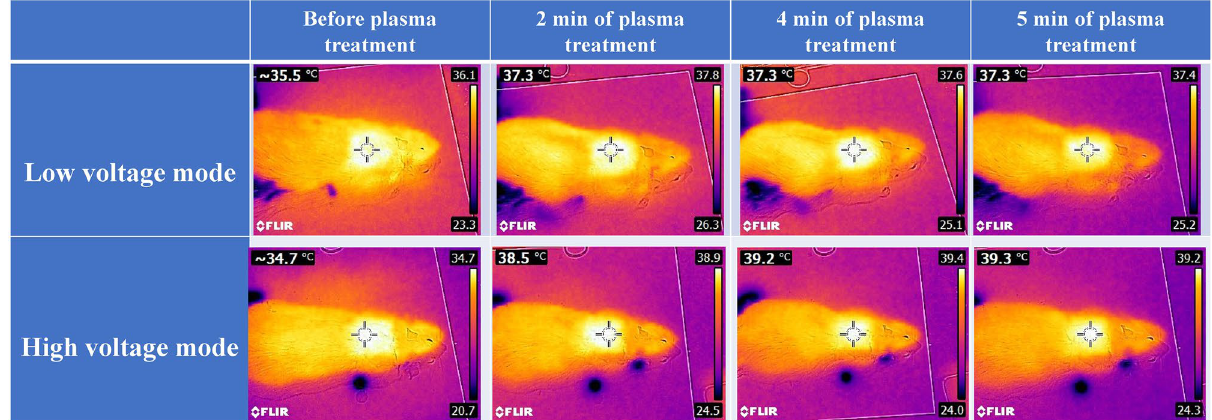
Figure 3. Skin temperatures of rats were measured by an infrared camera, before treatment and after 2, 4, and 5 min of treatment by low- and high-voltage modes of the plasma device.